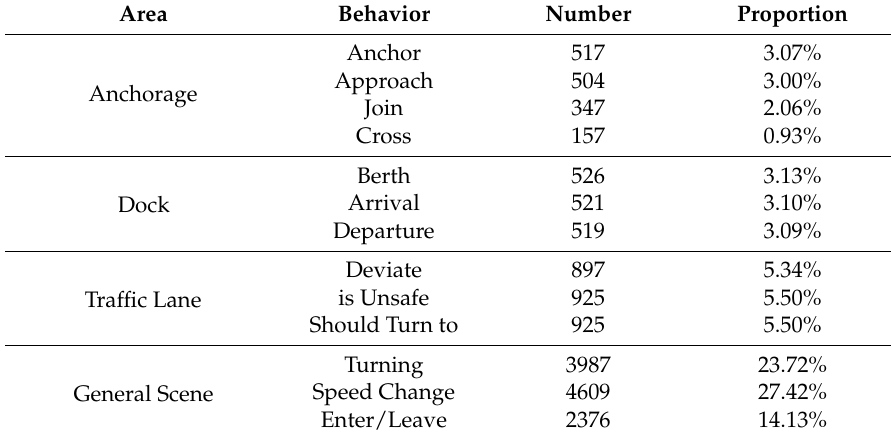
Table 5. Number and proportion of ship behaviors. The most of behaviors are Speed Change and Turning . Some ships berth/anchor at dock/anchorage all day, so the number of Berth / Anchor behavior is not equal to that of Arrival / Approach